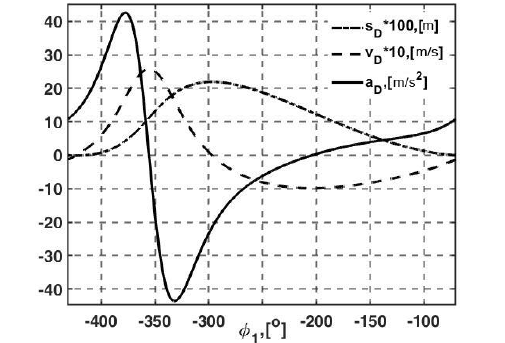
Fig. 2. Kinematic characteristics of the slider